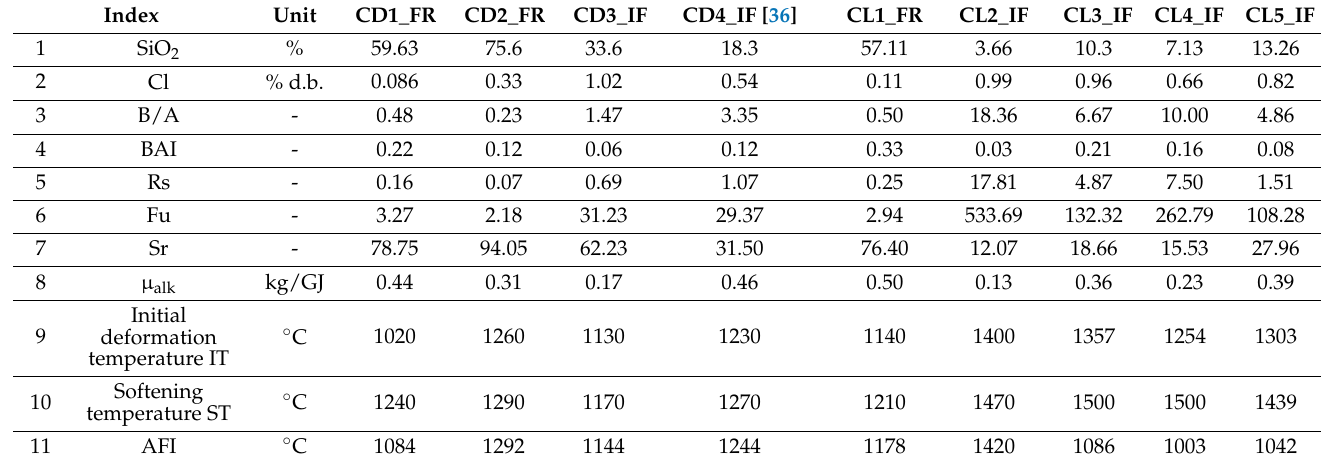
Table 3. Deposition hazard evaluation according to 11 prediction indices (d.b.—dry